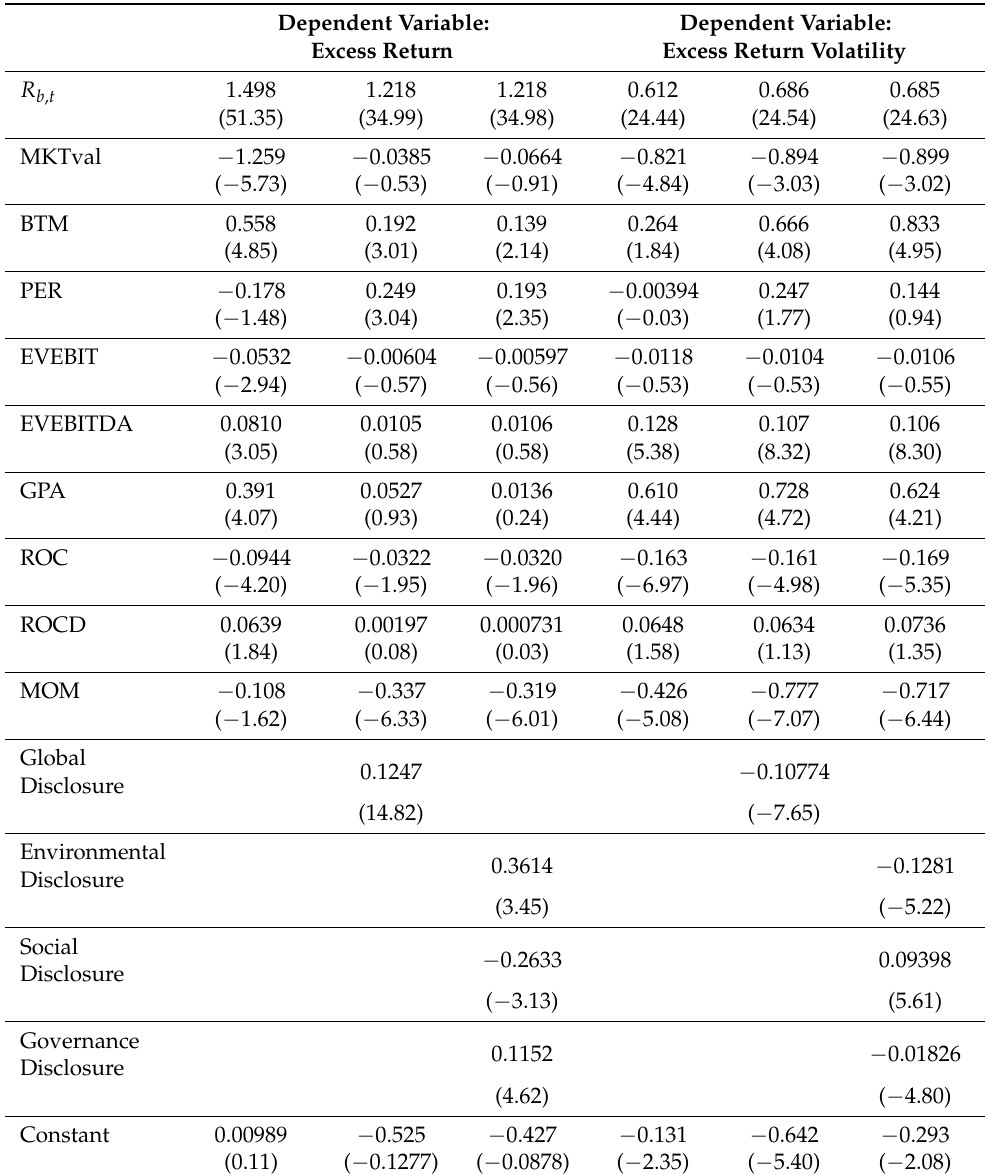
Table 5. Portfolio’s annualized excess returns and volatilities.